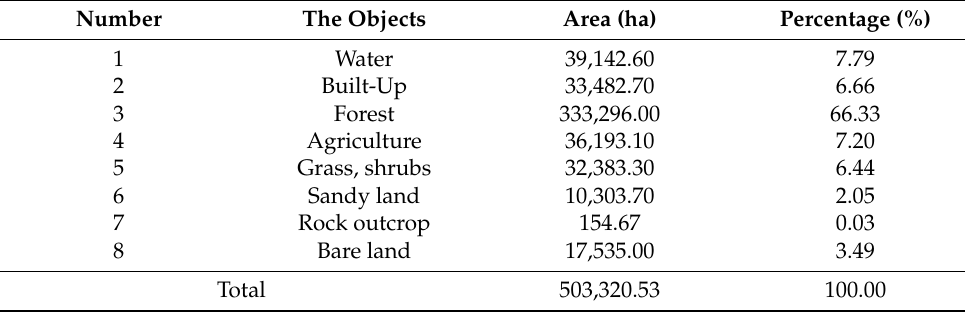
Figure 4. Land use/land cover extraction from Landsat 8 OLI in Thua Thien Hue. Table 4. Area of land use/land cover in Thua Thien Hue in